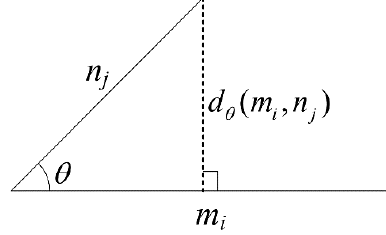
Figure 3. BSP algorithm flow chart. Algorithm1: BSP algorithm pseudo-code